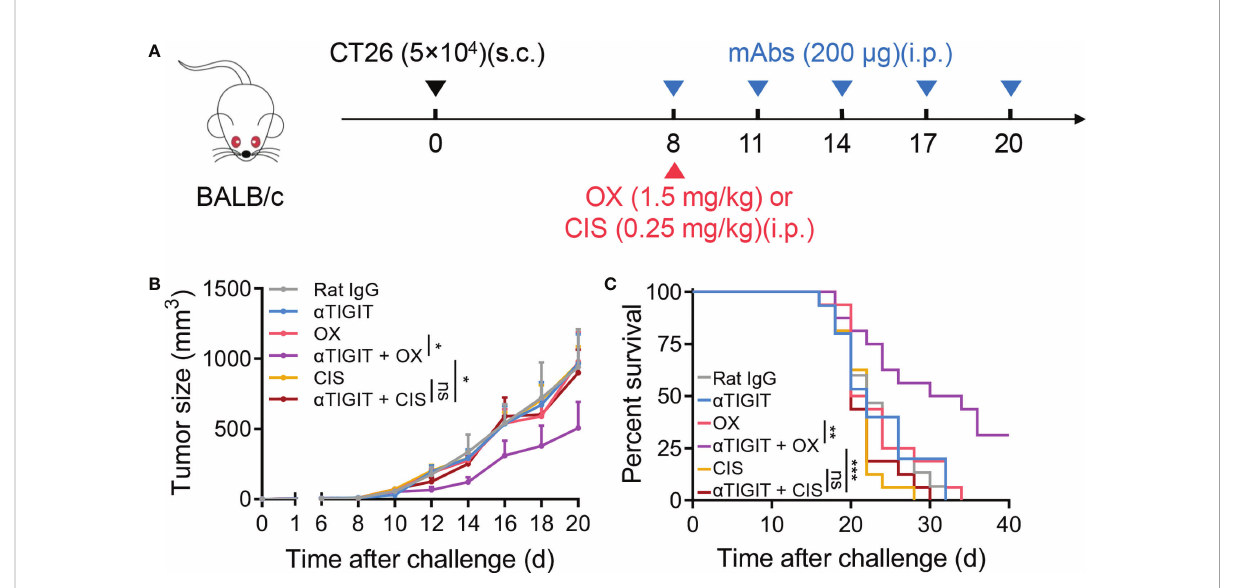
FIGURE 6 Low-dose cisplatin fails to promote anti-TIGIT mAb treatment against CT26 colon cancer. (A) , Experimental scheme for CT26 colon cancer model used in (B, C) : mice were given injection of Rat IgG, anti-TIGIT (10 mg/kg), OX (1.5 mg/kg), anti-TIGIT combined with OX, cisplatin (CIS, 0.25 mg/kg) or anti-TIGIT combined with CIS intraperitoneally ( i.p. ) after injection of 5×10 4 CT26 tumor cells subcutaneously ( s.c. ) on day 0. (B) , Tumor size measurement at each time point. (n=15-17 mice per group). (C) , Overall survival of CT26- bearing mice with various treatments. (n=7 or 8 mice per group). Data were representative of at least two independent experiments. Error bars represent means ± SEM. Statistical signi fi cance was determined using two-way ANNOVA (B) or Mantel – Cox test (C) . ns, p > 0.05; *p < 0.05; **p < 0.01 and ***p <